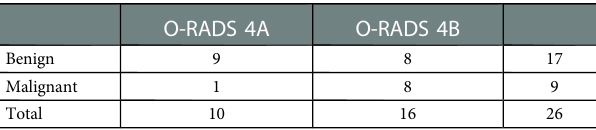
TABLE 4 Malignant risk in sub-groups of O-RADS 4